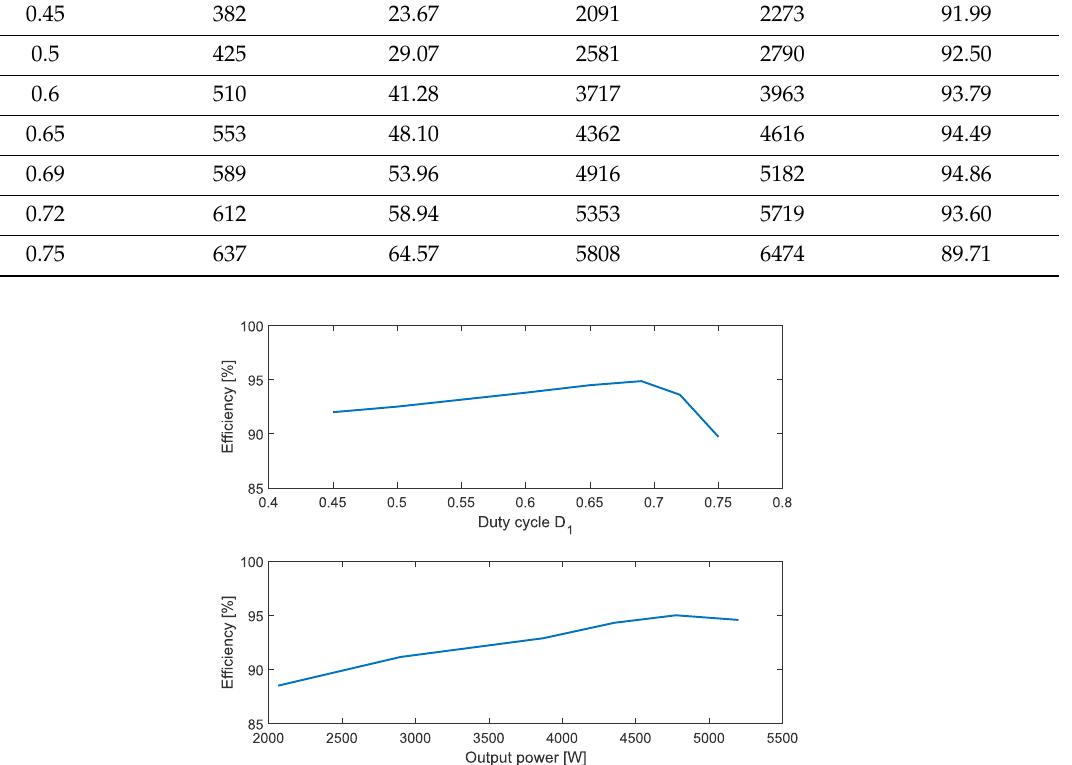
Table 4. Efficiency results with constant output voltage.